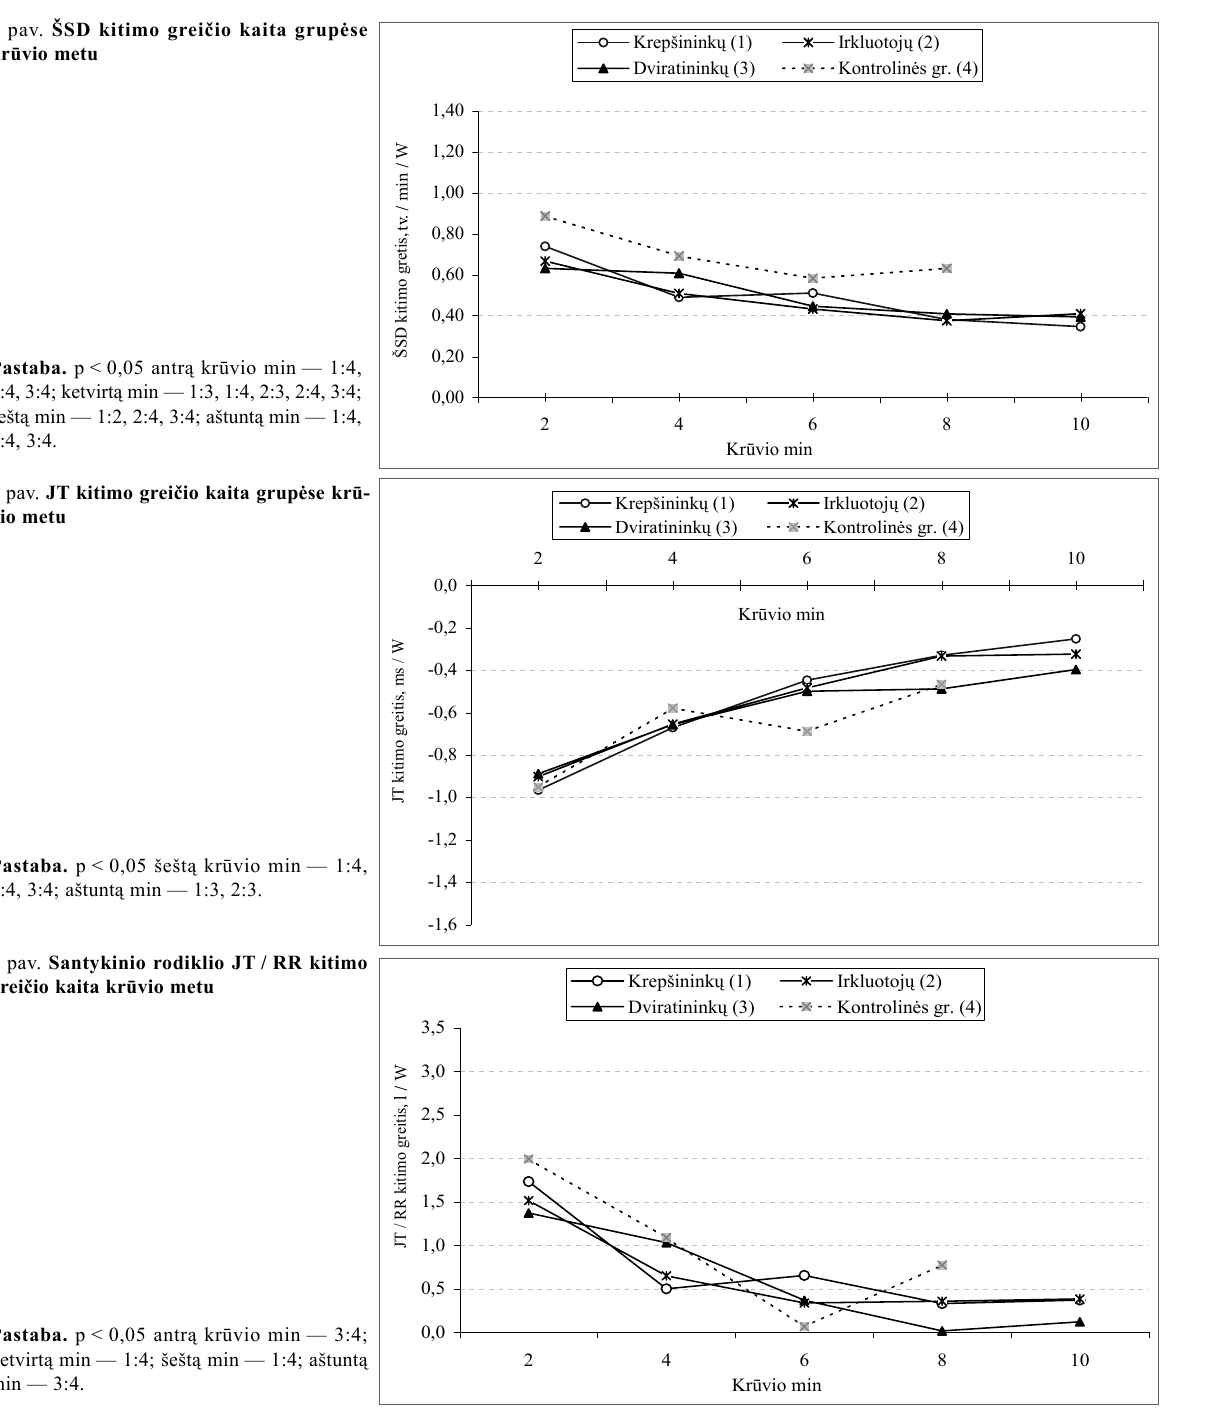
padid ė ja. Iki šeštos minut ė s kontrolin ė s grup ė s tiriam ų j ų (S-D) kitimo greitis tolygiai maž ė ja, šešt ą minut ę yra mažiausias, nuo šeštos — did ė ja. Antr ą , šešt ą ir aštunt ą minut ę išryšk ė jo statistiškai reikšmingas (S-D) kitimo grei č io skirtumas tarp tiriam ų j ų grupi ų (p < 0,05). Rezultatai parod ė KSMM koreliacij ą su ŠSD, JT, S kitimo grei č iais. Antr ą , ketvirt ą ir aštunt ą fi zinio kr ū vio minut ę išryšk ė ja neigiamas kore- liacinis ryšys tarp KSMM ir ŠSD kitimo grei č io (r = –0,3), dešimt ą minut ę nustatytas stipresnis